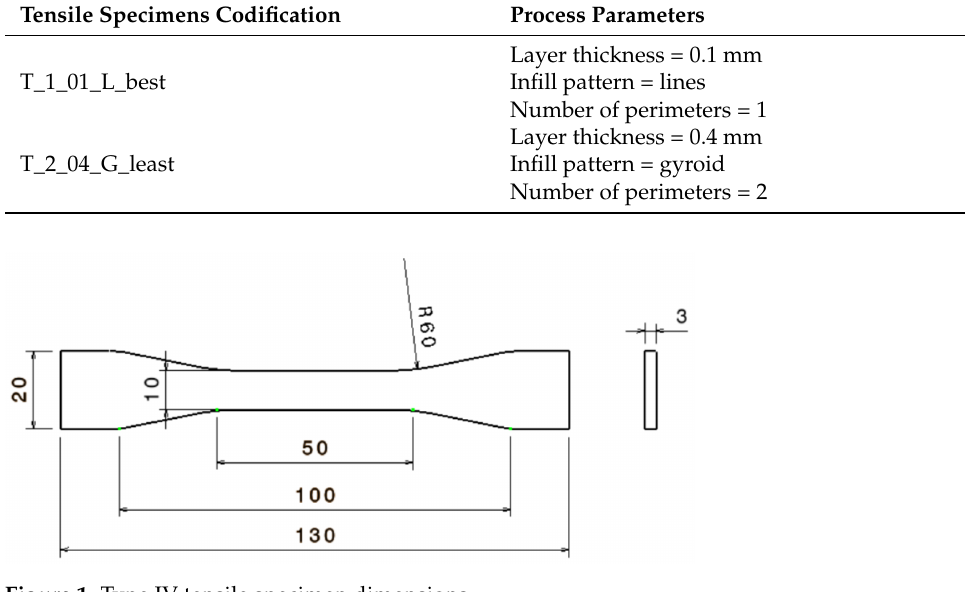
Figure 1. Type IV tensile specimen dimensions.